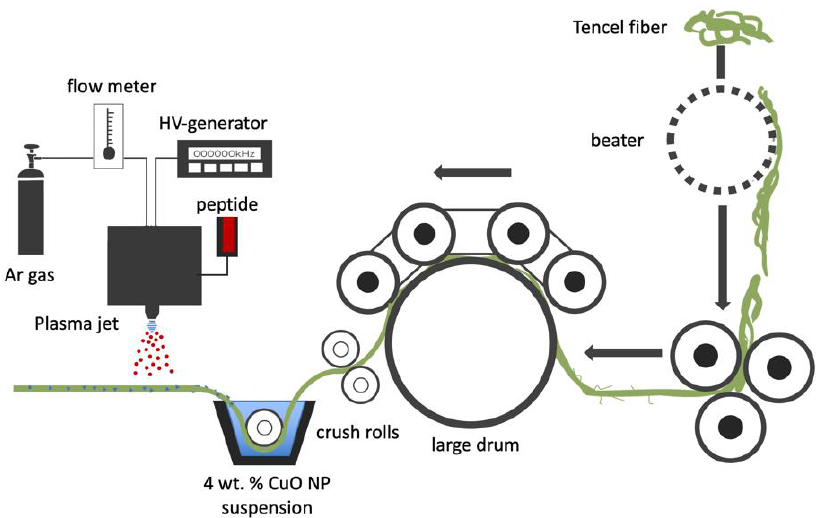
Figure 1. Schematic of the fabrication sequence of peptide-coated nano-CuO/Tencel.